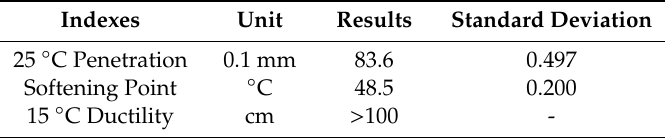
Table 2. Main technical indicators of 90# matrix asphalt.